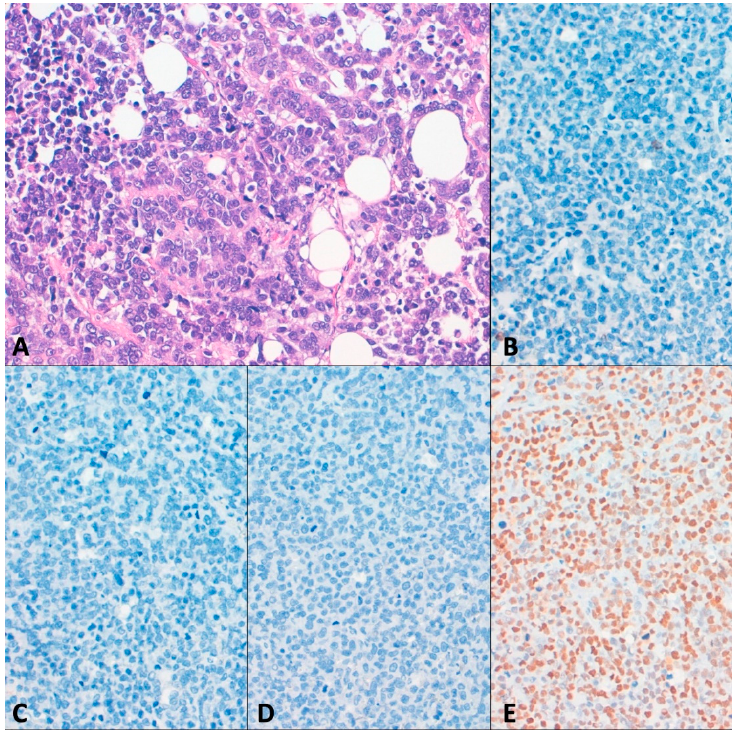
Figure 4. MMR proficient tumor 30 ( A ) Hematoxylin–eosin staining showing a solid tumor. There was absence of expression of ( B ) CDX2 and ( C ) CK20. In addition, ( D ) E-cadherin expression was lost. ( E ) p53 had an aberrant pattern without any mutation in TP53 discovered by NGS analysis. Cancers 2021 , 13